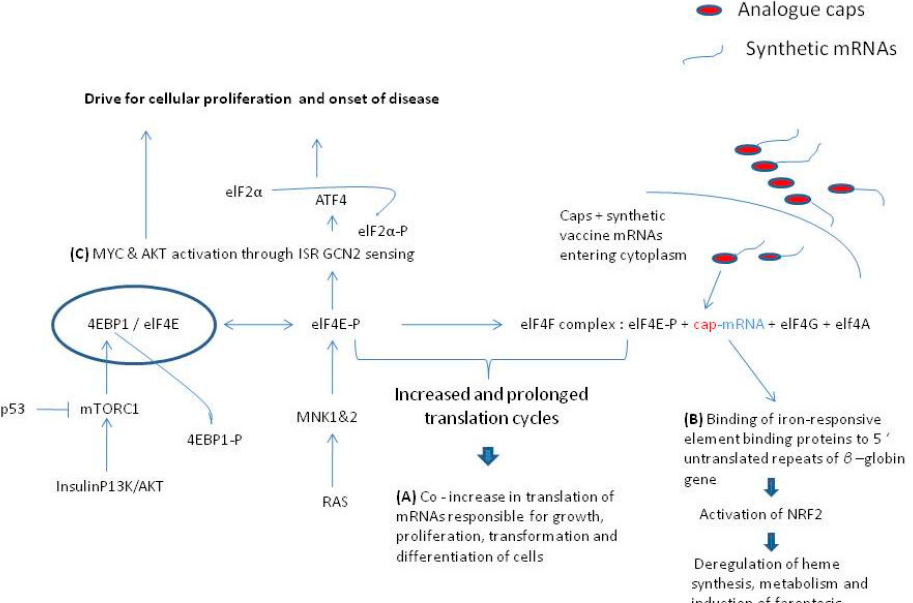
Figure 1. Pathways that lead to disease from the prolonged phosphorylation of elF4E 209 serine. ( A ) Intense cap binding to the p-elF4E and elf4G complex facilitates the co-translation of cellular proliferation proteins (C-MYC, cyclin D1, Bcl-2 and others) [25,26]. ( B ) Prolonged presence of 5 ′ untranslated repeats of β -globin gene of mRNAs are attractant to the activation of NRF 2 protein that induces ferroptosis [41–44]. ( C ) Prolonged presence of phosphorylated form of elF4E (p-elF4E) is said to activate ISR GCN2 sensing and drive cellular proliferation to induce auto-immunity and oncogenesis [31,34,36–40].